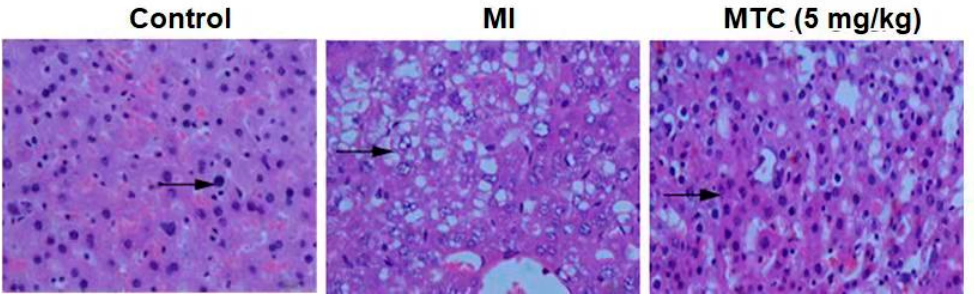
Figure 9. Protective effect of MTC (5 mg/kg) on injured hippocampus induced by ischemia reperfu- sion in rats, the black arrow point to nucleus.